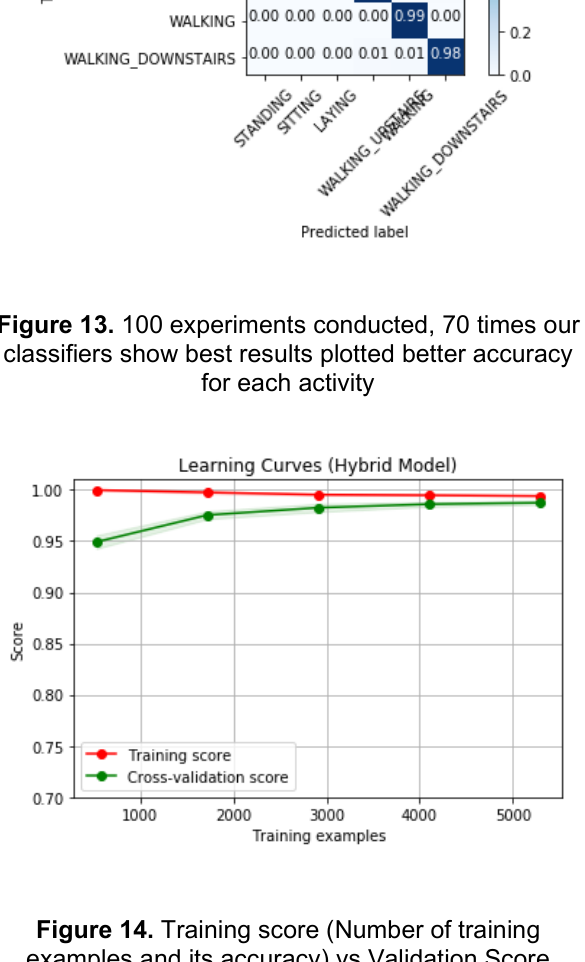
Table 1. Comparison Results of different